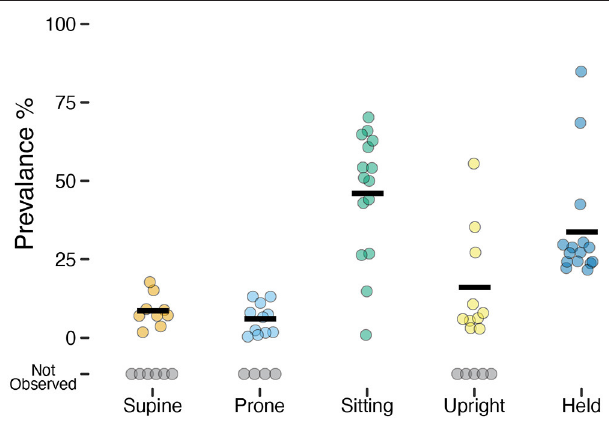
FIGURE 2 | Prevalence of each position observed in the laboratory study. Each individual circle is the prevalence (% of time) for one participant; gray circles indicate participants for whom a position was not observed. Horizontal black lines show the mean prevalence for each position among infants for whom that position was observed.